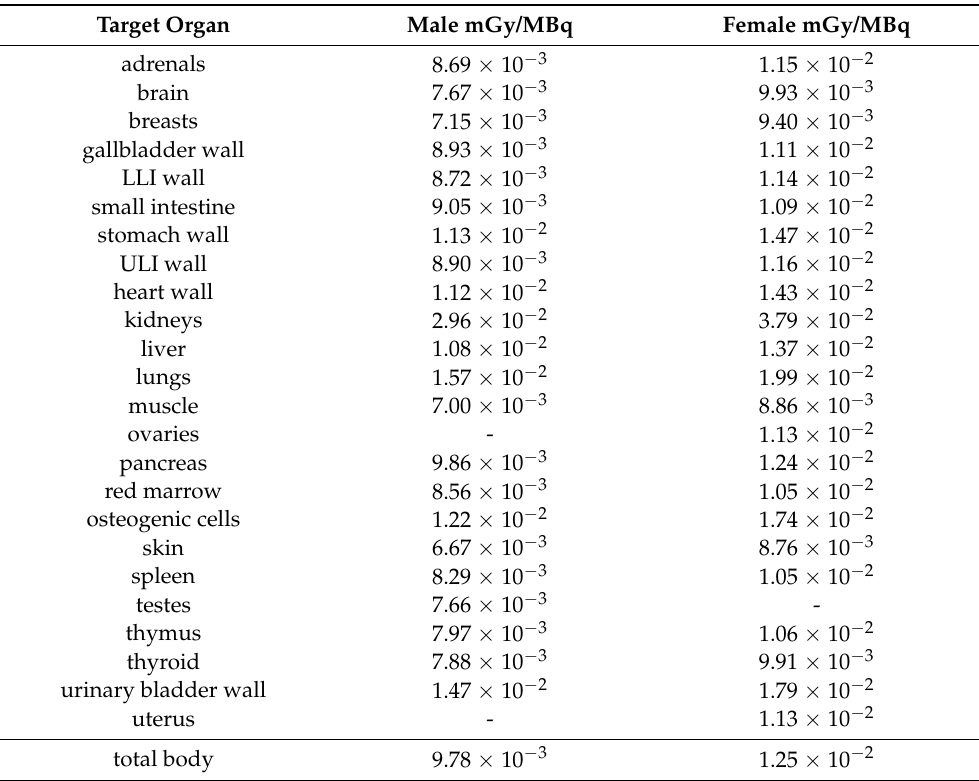
Table 4. Expected organ absorbed doses of 68 Ga-DOTA-MGS5 in humans based on extrapolation of the biodistribution data from mice to